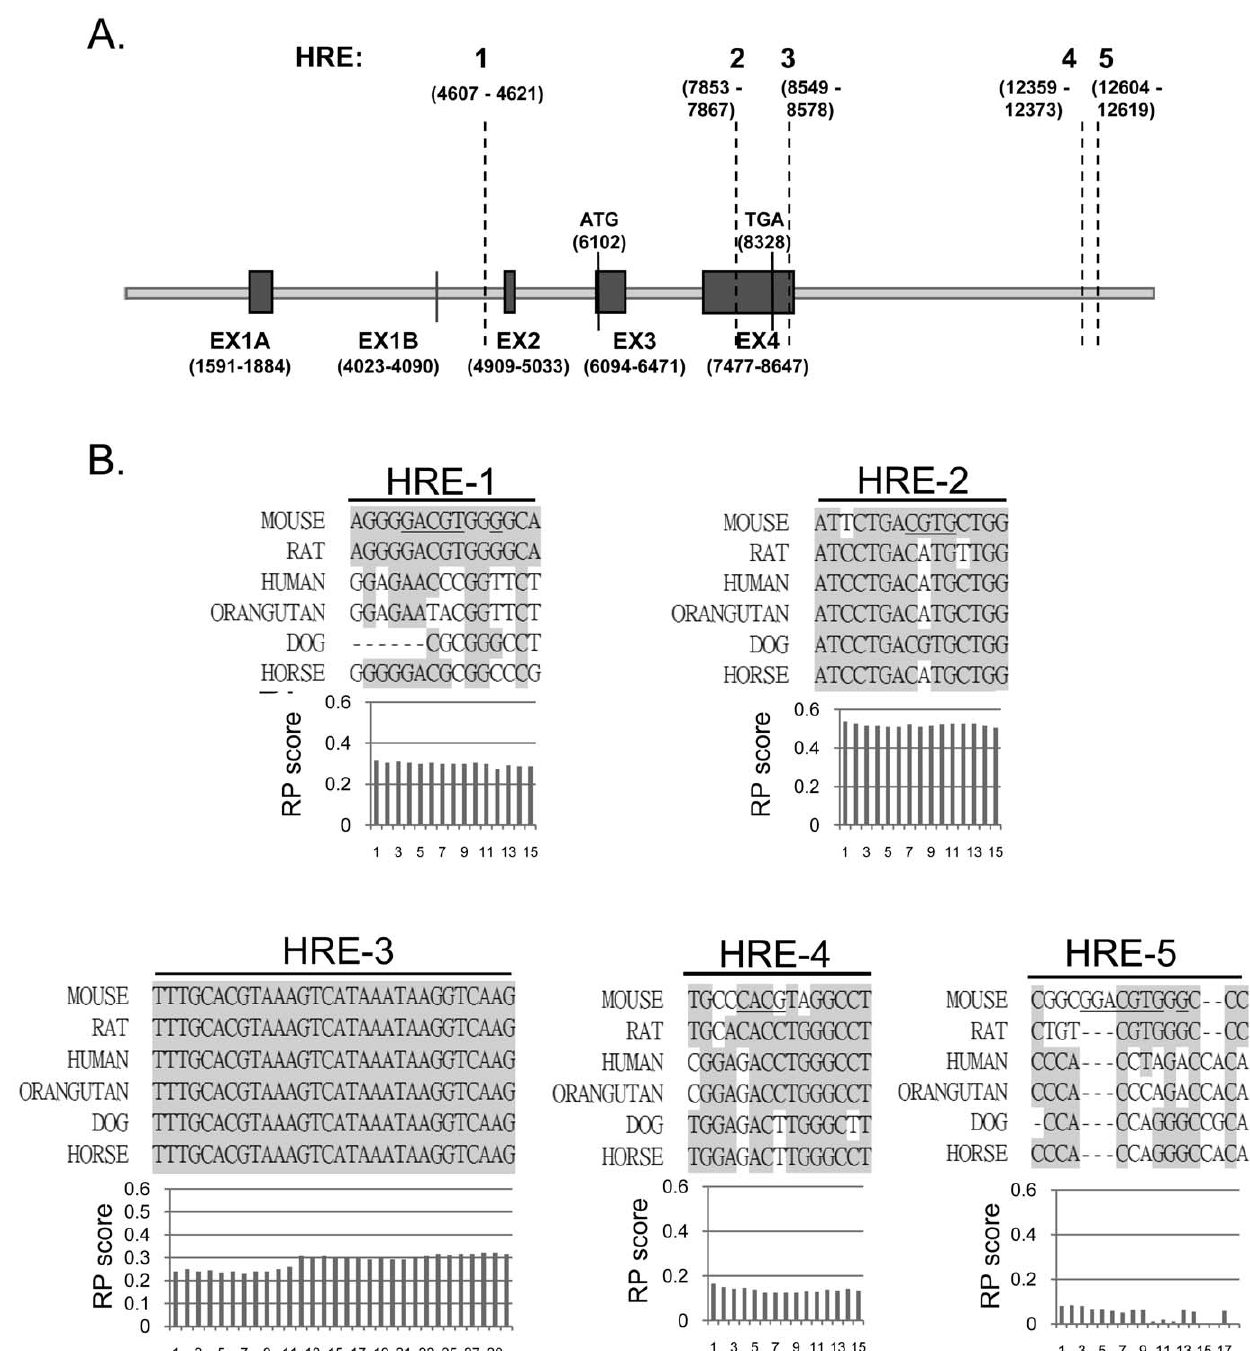
Figure 3. Identification of putative HREs in the murine BMP4 gene. (A) Schematic diagram of the location of the 5 putative HREs in BMP4 locus with extra 5000 bp both upstream and downstream, where the transcription start site is located at 6102 bp. The acquired sequence data were from September 2005. (B) The sequences of the 5 putative HREs are aligned among mammals. Sequences in grey box are conserved among 6 species. Below each alignment is the ESPERR 7 species RP score for each nucleotide.